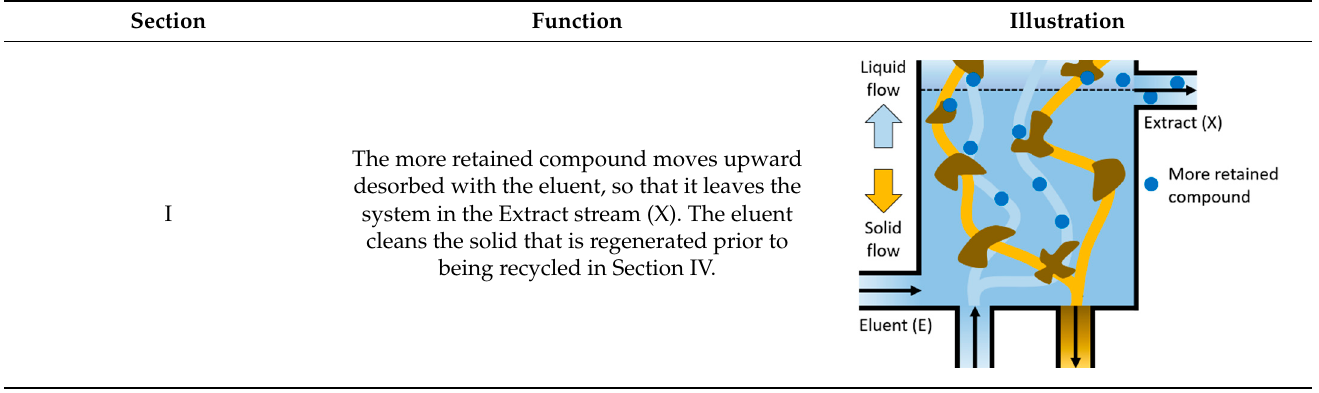
Figure 13. Schematic diagram of a TMB chromatograph. Table 10. Functions of the TMB sections.